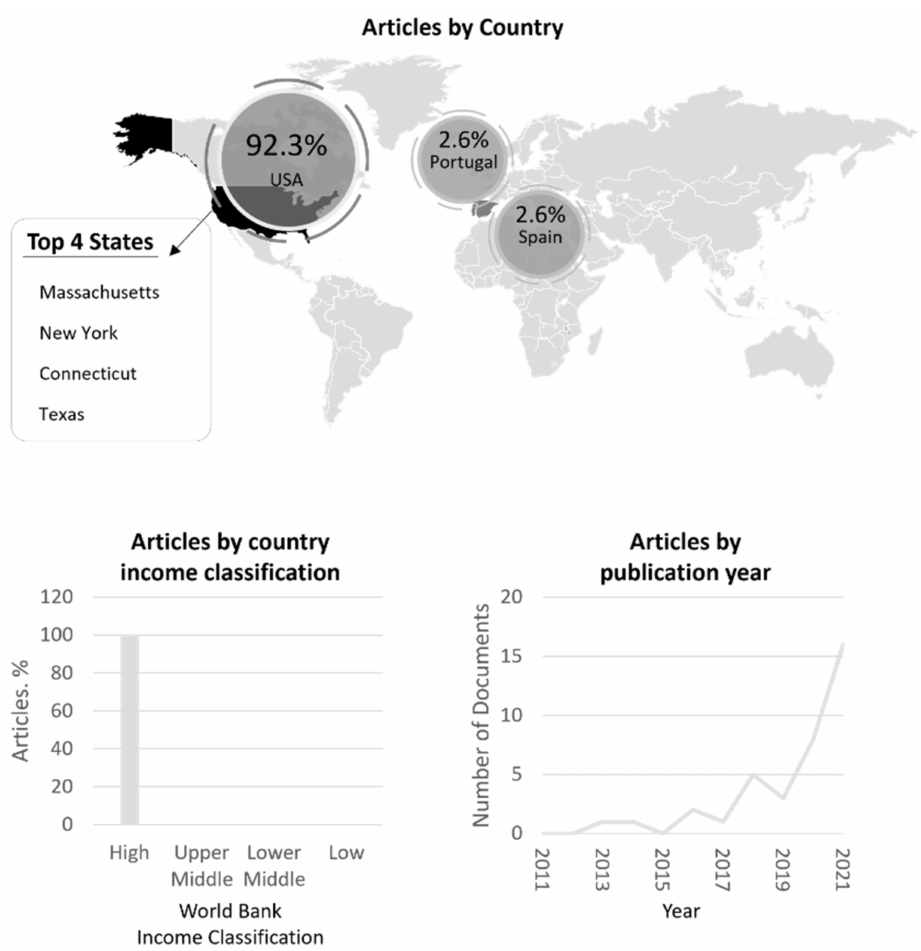
Figure 2. Article characteristics by setting, income status, and publication